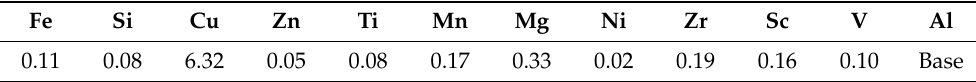
Table 1. Chemical composition of AA2519 alloy.